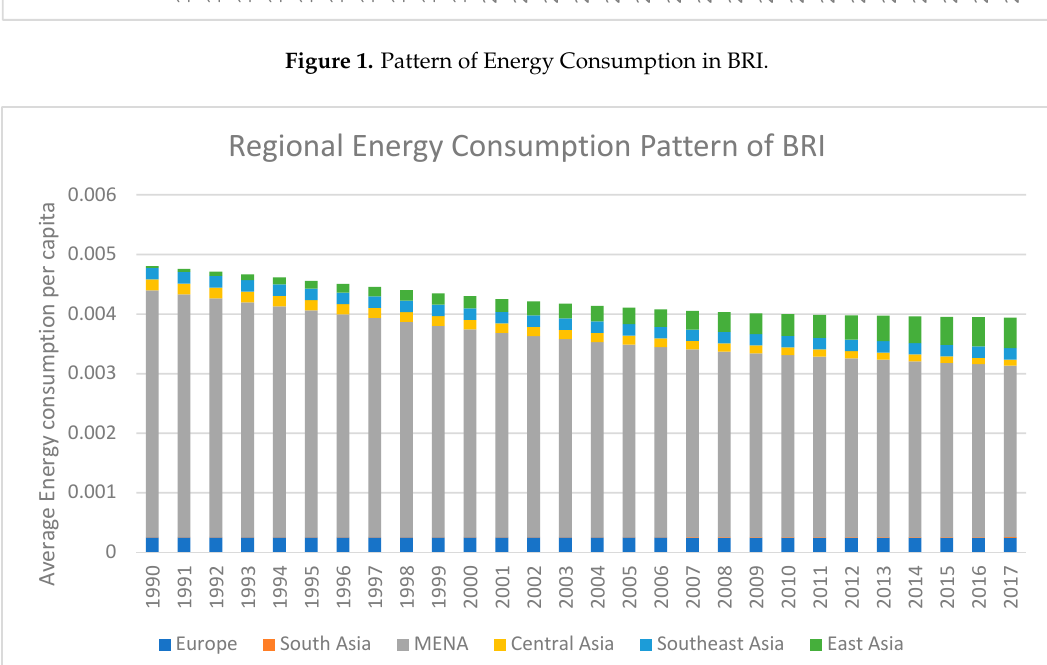
Figure 2. Regional Patterns of Energy Consumption in BRI.